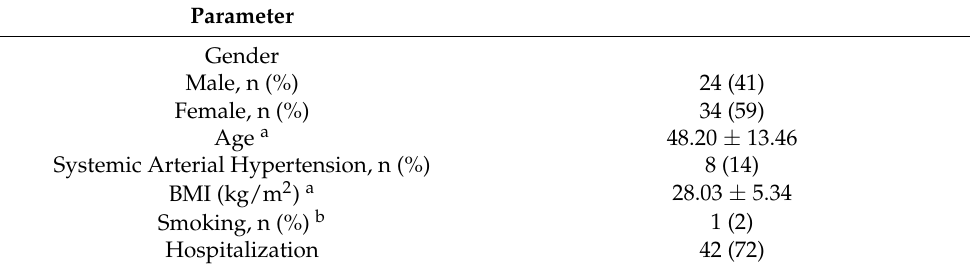
Table 1. The characteristics of 58 patients with COVID-19. Parameter